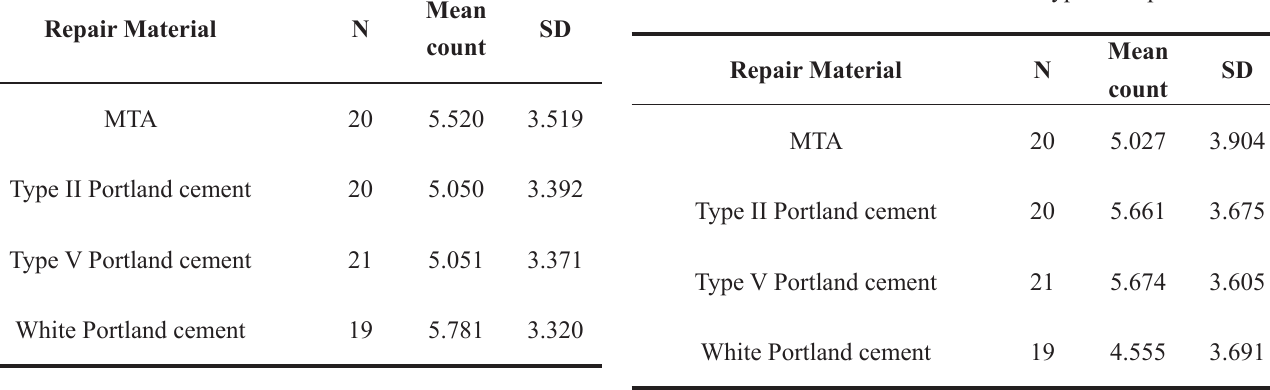
FIGURE 3 – Micrographs of furcation perforations treated with the different cements showing the repair material ( C ) and newly formed bone ( O ). ( A , B ) Furcation perforations treated with Type II Portland cement ( CPII ). ( C , D ) Furcation perforations treated with mineral trioxide aggregate ( MTA ). ( E , F ) Furcation perforations treated with white Portland cement ( CPB ). ( G , H , I ) Furcation perforations treated with Type V TABLE 1 – Number of grid points counted on newly formed bone shown in digital images of histological sections of TABLE 2 – Number of grid points counted on teeth treated with the different types of repair materials. inflammatory infiltrate shown in digital images of histological sections of teeth treated with the different types of repair